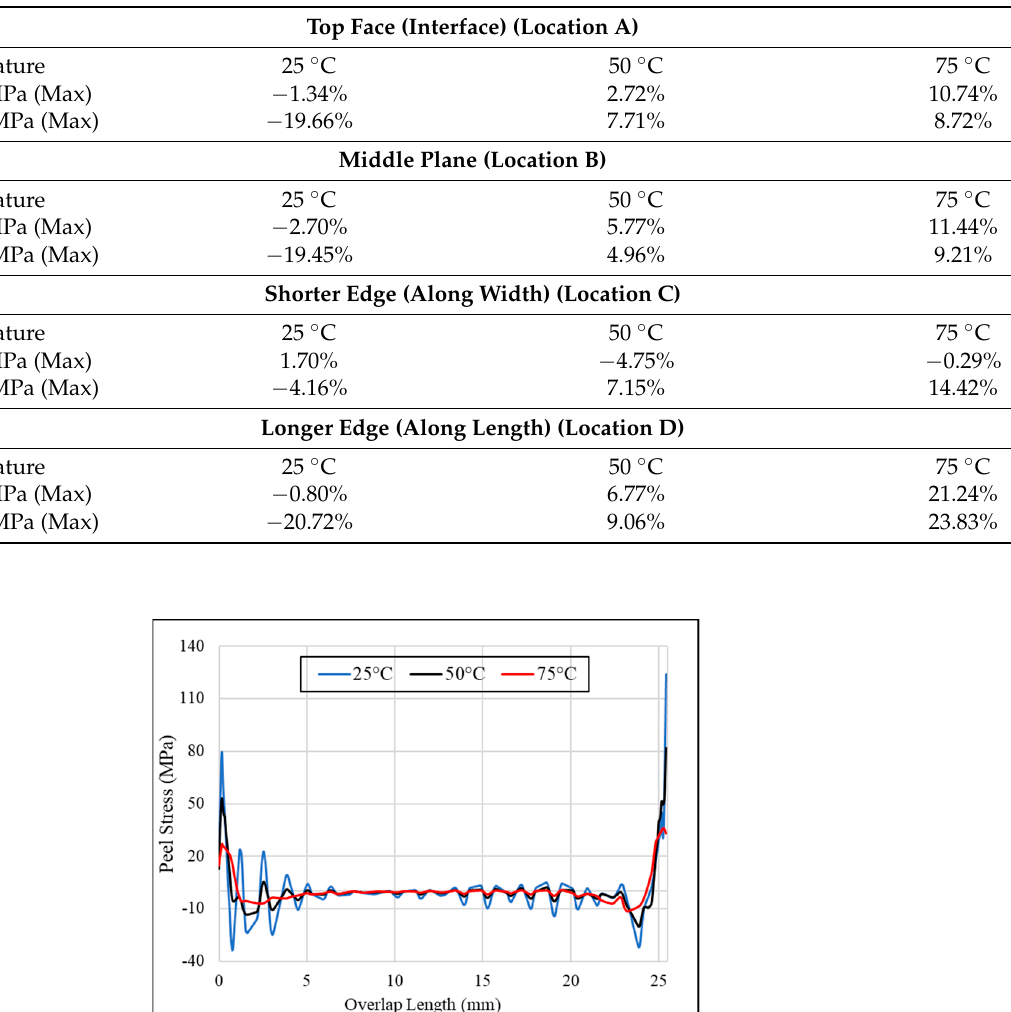
Table 3. Comparison of Percentage Change in Peel Stress and Shear Stress with the Inclusion of